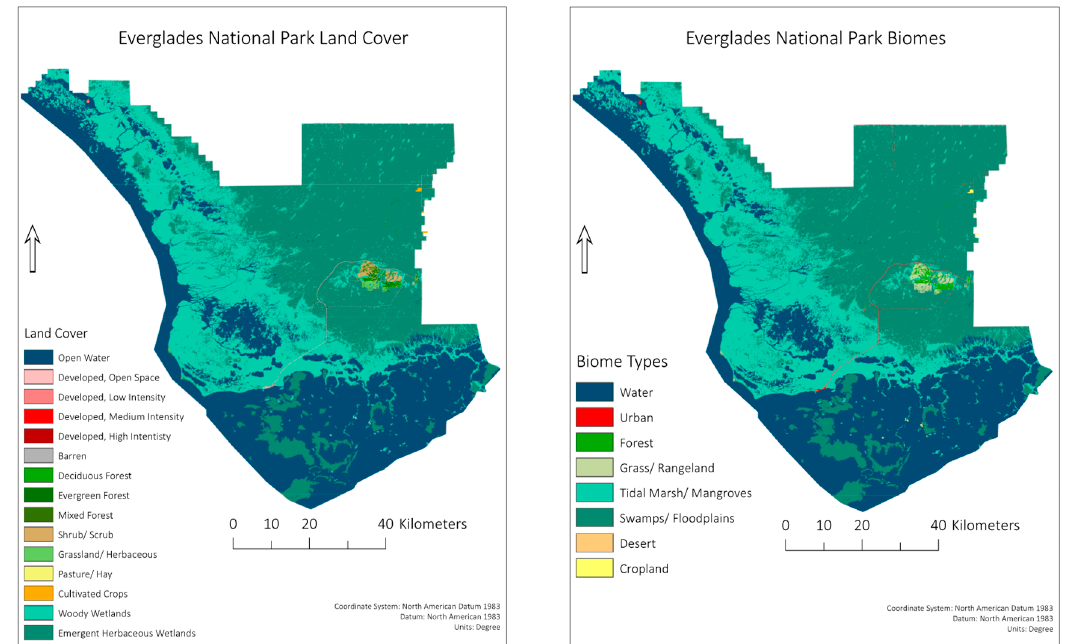
Figure 3. Everglades National Park Land Cover and Biomes.